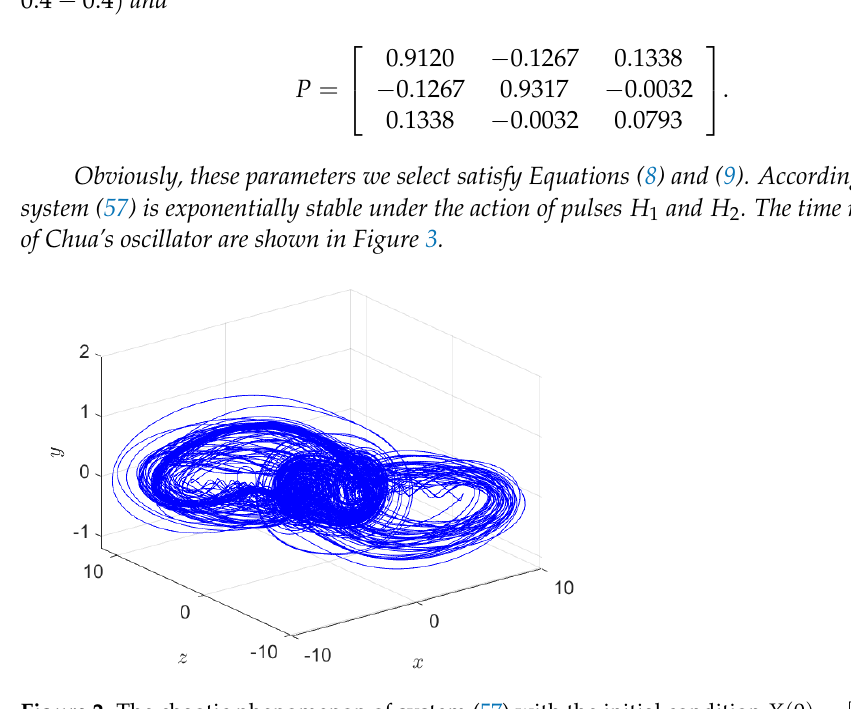
Figure 2. The chaotic phenomenon of system (57) with the initial condition X ( 0 ) = [ 4,0, − 3 ] T .